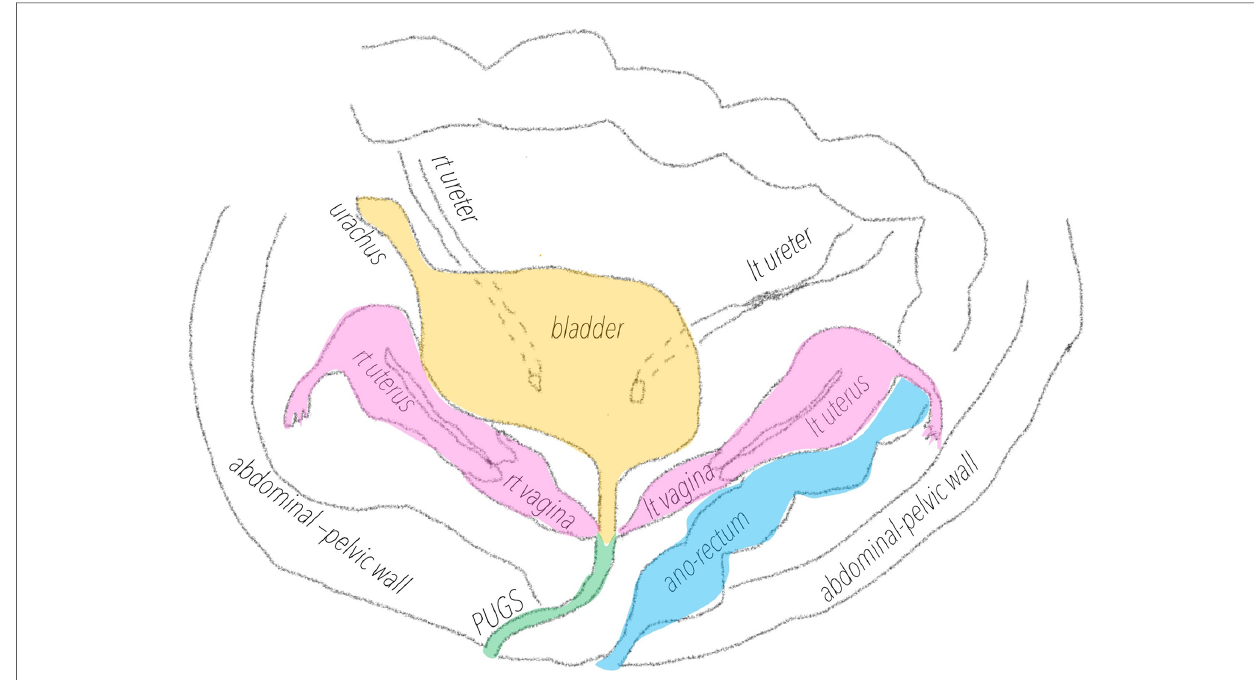
FIGURE 4 Schematic representation of PUGS and the associated Mullerian